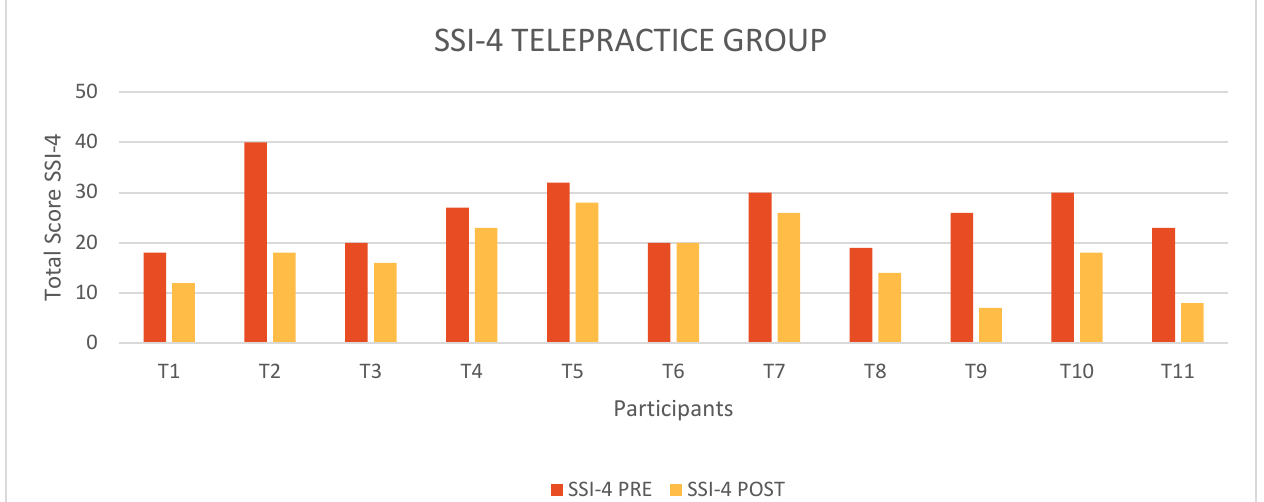
SSI-4 total score pre and post treatment Telepractice